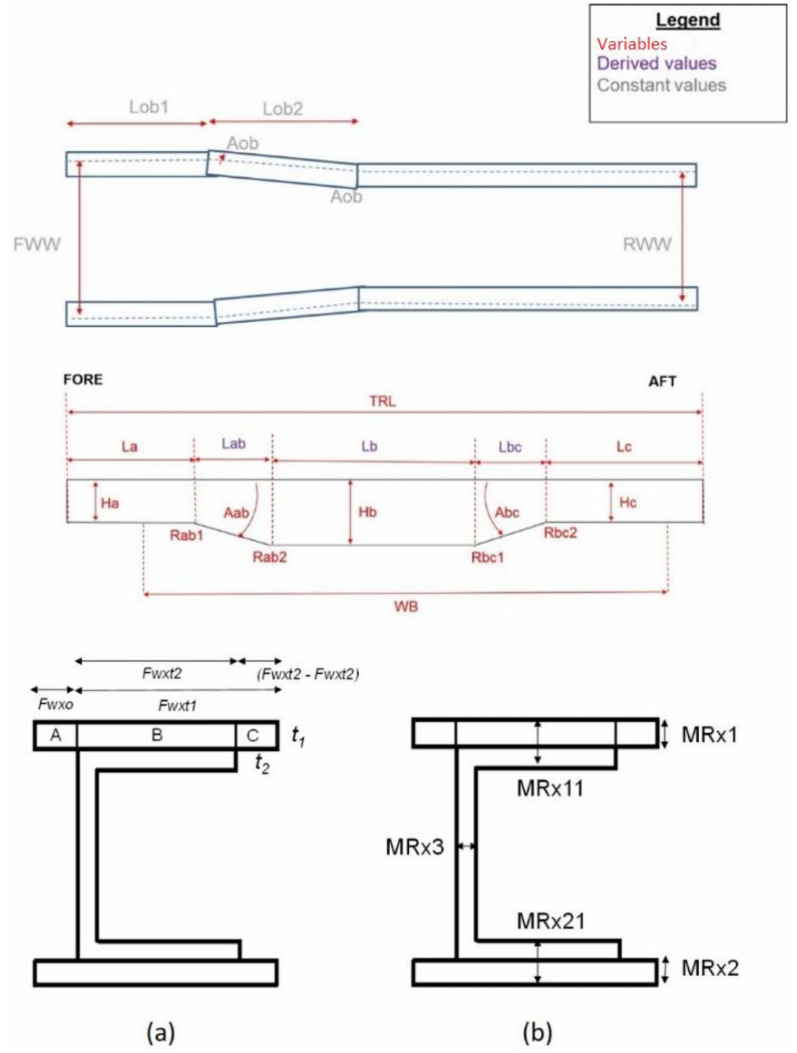
Figure 1. ( a ) Top view and side view of rail; ( b ) cross section of side rail (consisting of C-section with top and bottom